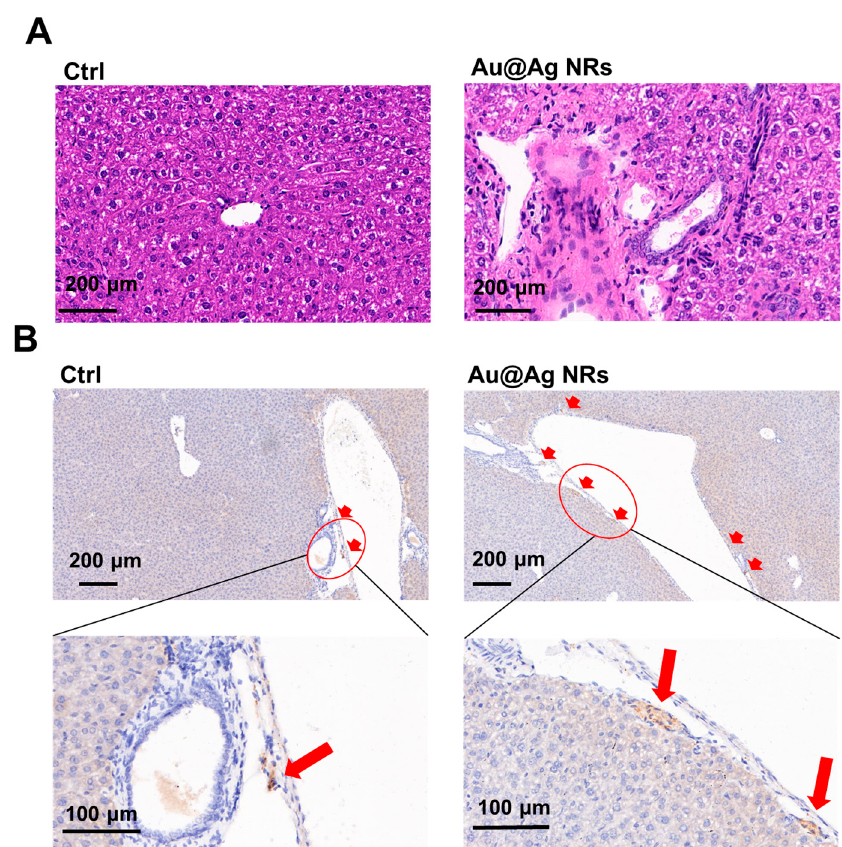
Figure 3. Influence of Au@Ag NRs on liver tissue. ( A ) histological images of liver from mice received multiple administration of Au@Ag NRs. The tissues were stained with hematoxylin and eosin; ( B ) the level of tyrosine hydroxylase (TH) expression in liver visualized by immunohistochemical staining, indicated by red arrows.